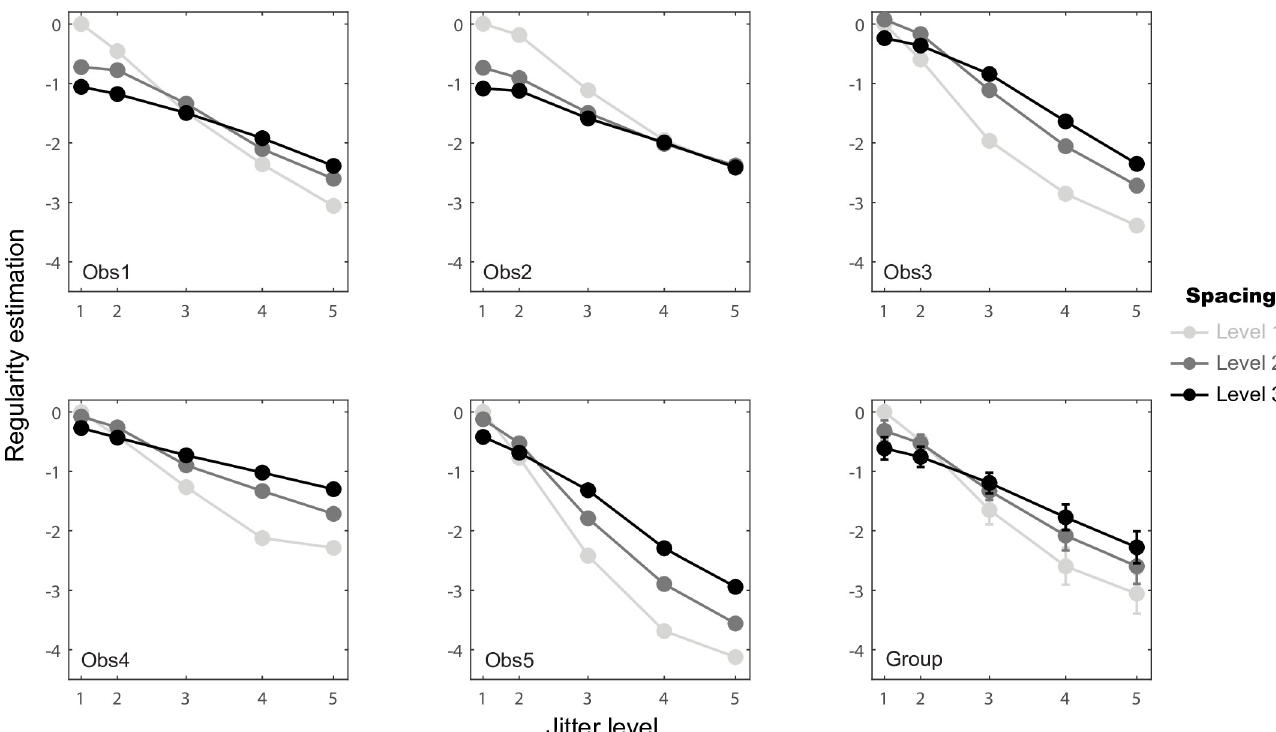
Fig 5. Element spacing × jitter interaction based on the coefficients of statistical Model 8. Estimated regularity values are plotted against jitter level (corresponding to the proportion of the averaged Pythagorean distance of the resulting element positions as in Fig 4) for the three element spacing levels separately (light to dark lines). Group data were calculated by pooling the individual data values together across the five observers and calculating their means and standard errors for each condition.